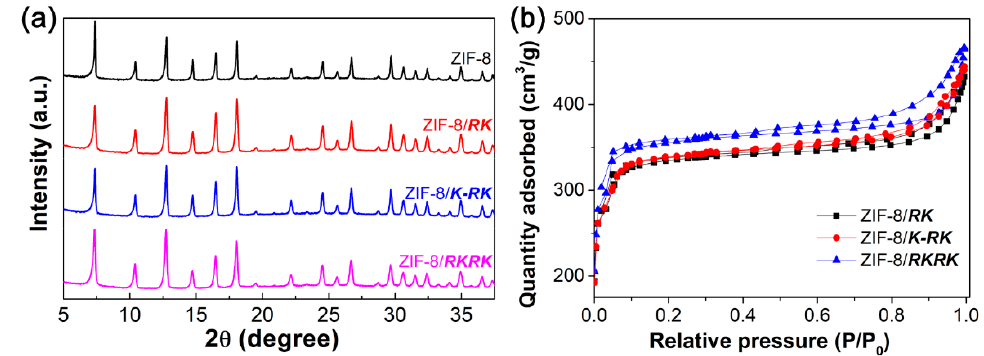
Figure 5. XRD patterns ( a ) and N 2 adsorption isotherms ( b ) of the ZIF-8 crystals prepared in pure water or in the presence of each